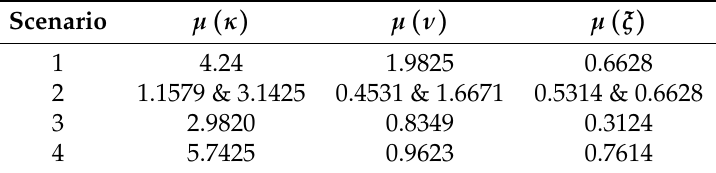
Table 8. Main SITL outputs (single run).